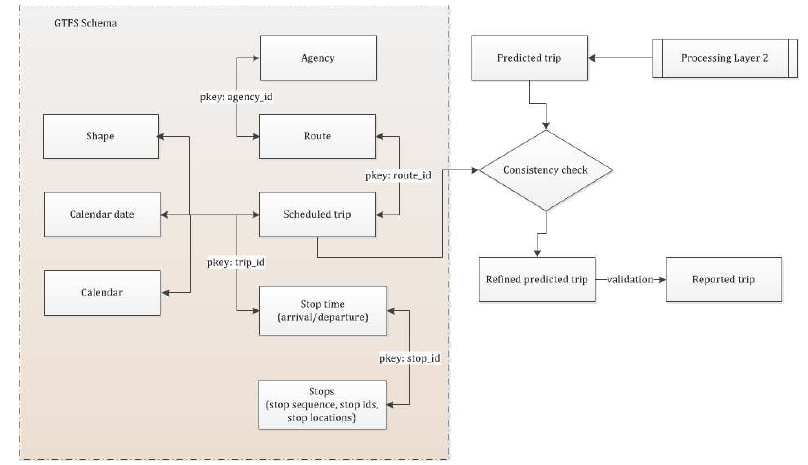
Figure 4. General transit feed specification (GTFS) schema and consistency check between the predicted trip and the scheduled